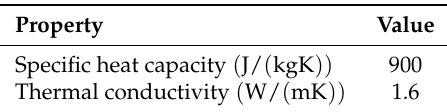
Table 4. Thermal properties of concrete at room